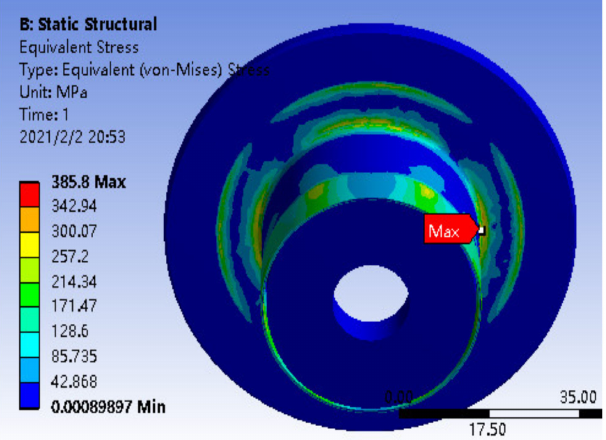
Figure 9. Equivalent stress of flexspline with improved cam wave generator.